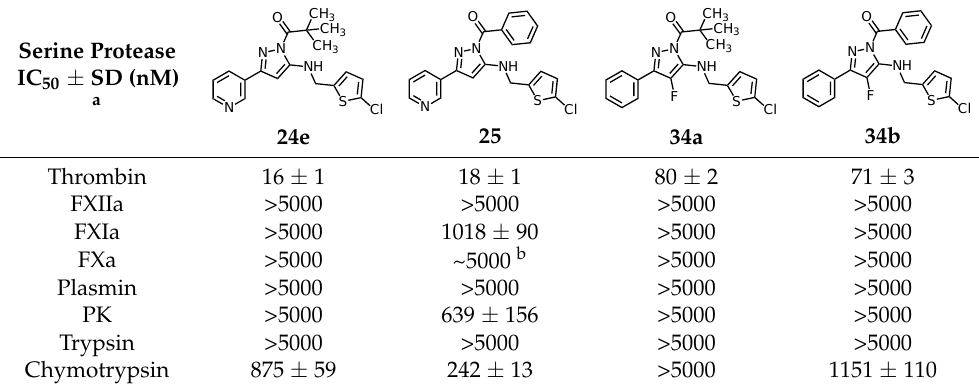
Table 4. Selectivity Profile of Acylated 1 H -pyrazol-5-amines 24e , 25 , 34a , and 34b . Serine Protease